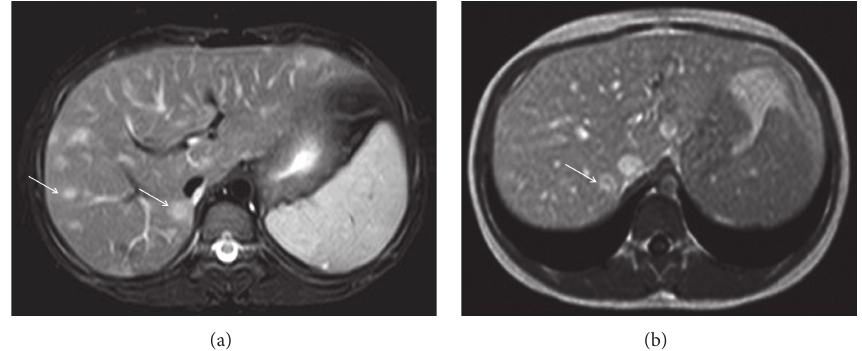
F 2: Follow-up abdominal MRI, axial images through the liver: the lesions (arrows) seen in Figure 1 present signs of maturity. eir margin is more distinct (STIR image in (a)), as edema has resolved, and the peripheral enhancing rim is better de�ned (T1W image a�er IV contrast administration in